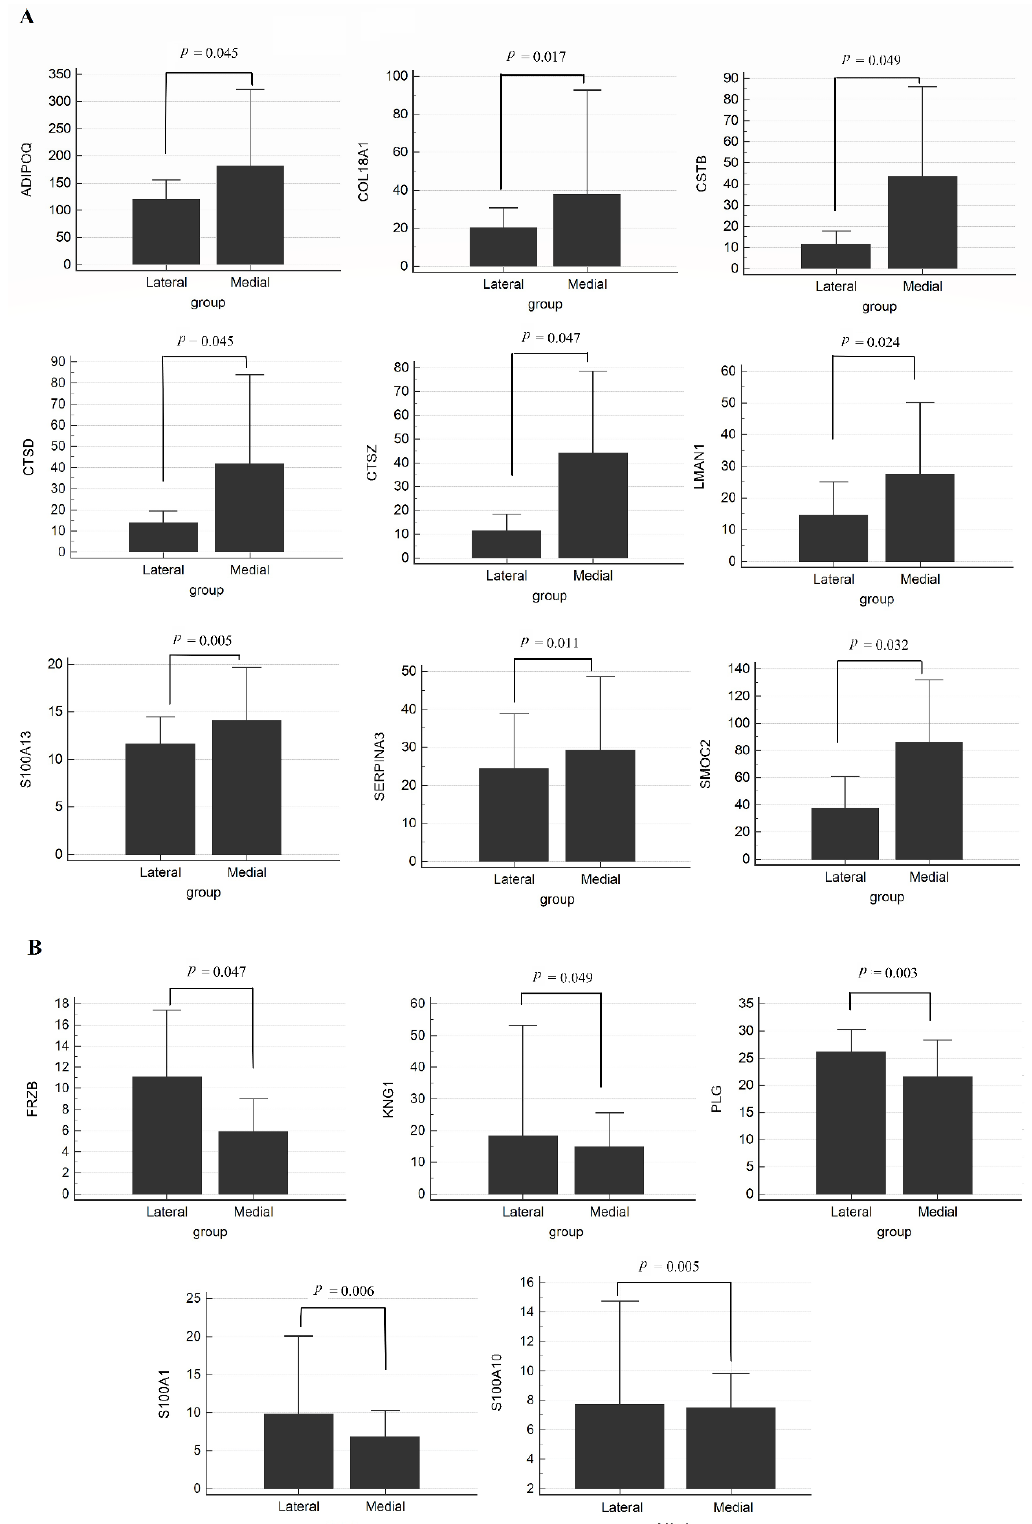
Figure 1. MRM results of meniscal tissues. ( A ) Increased proteins in medial lesions, ( B ) Decreased proteins in medial lesions by the Wilcoxon test. A p -value < 0.05 is statistically significant.